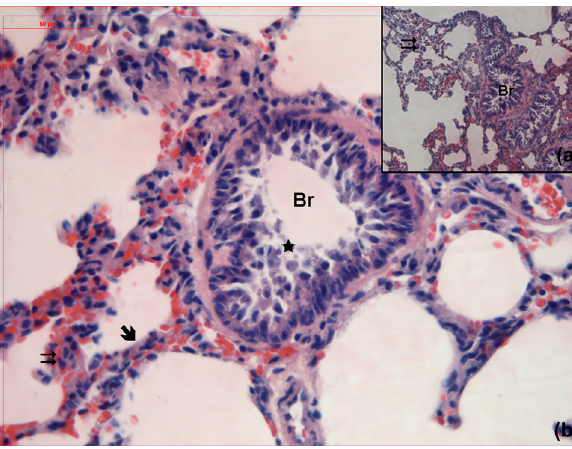
Figure 4: Hematoxylin – eosin - stained lung samples obtained from the group treated with remifentanil. Br: bronchioles, (cid:2) : alveoli, (cid:3) : interalveolar septa, (cid:2) : cell debris ( hematoxylin – eosin, A: × 100, B: × 400 ) .